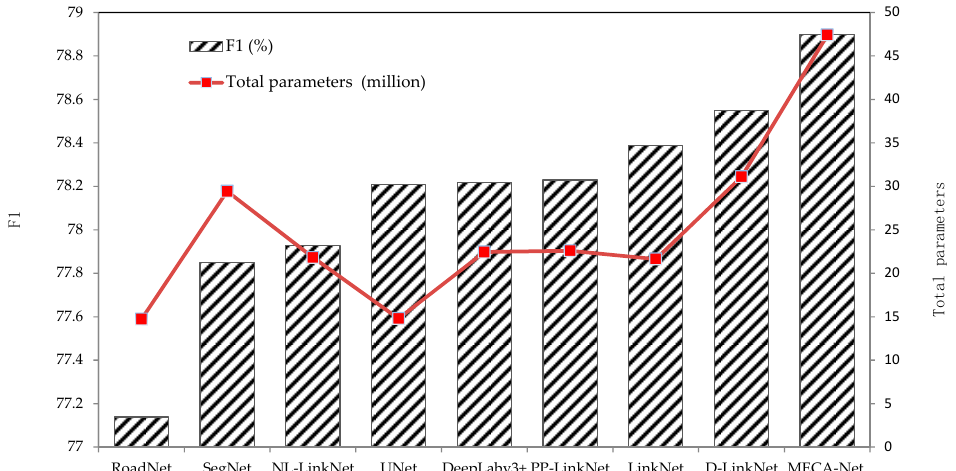
Figure 10. Comparison of the F1 value and parameter number of different networks on the DeepGlobe dataset. The bar chart and line chart represent the F1 value and the number of parameters of each network, respectively.